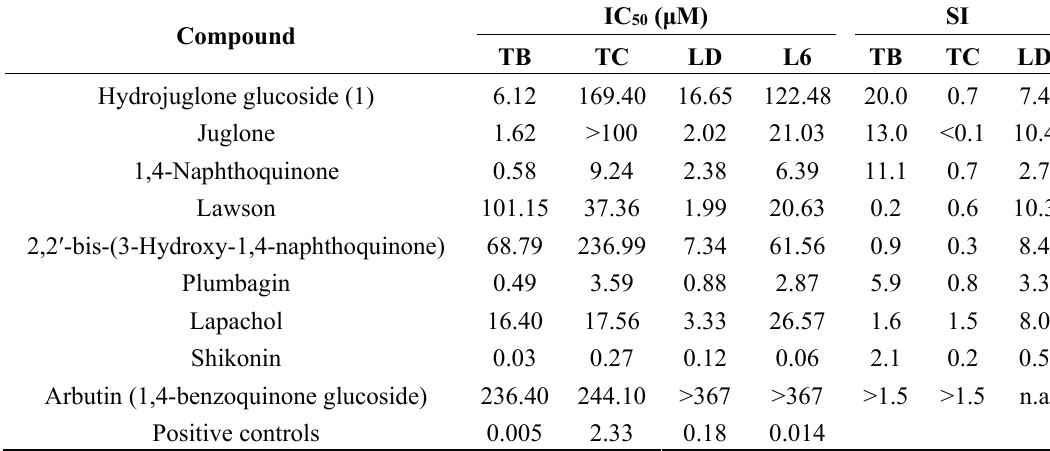
Table 3. IC 50 values against Trypanosoma brucei rhodesiense (TB), T. cruzi (TC), Leishmania donovani (LD) and rat skeletal myoblasts (L6). Selectivity indices (SI) represent the ratio of cytotoxic over antiparasitic IC 50